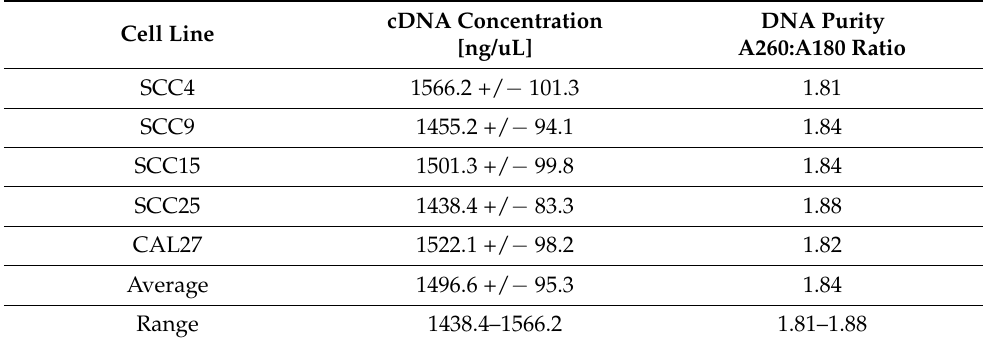
Table 2. Analysis of cDNA concentration and purity.